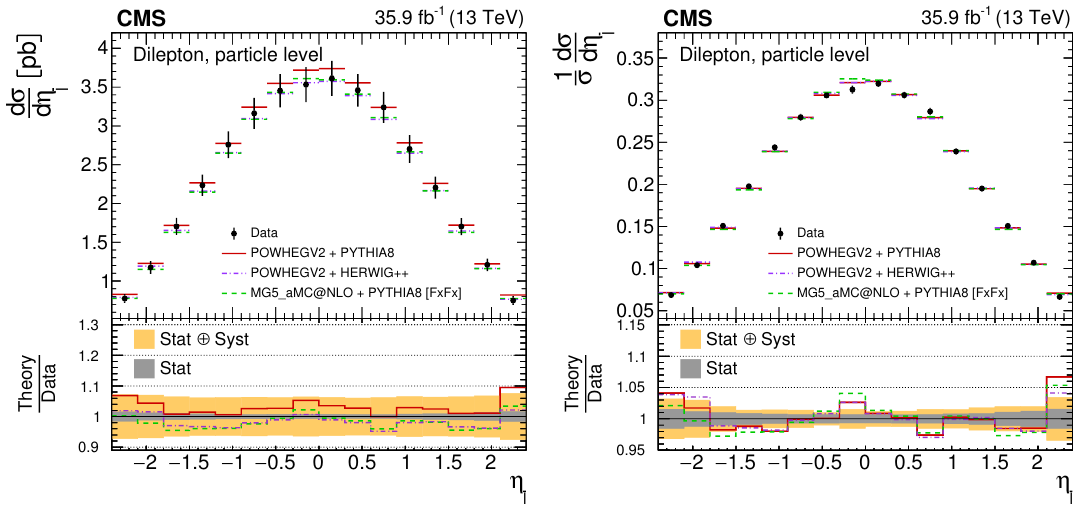
Figure 38 . The di(cid:11)erential tt production cross sections as a function of (cid:17) (cid:22) at the particle level are shown for the data (points) and the MC predictions (lines). The vertical lines on the points indicate the total uncertainty in the data. The left and right plots correspond to absolute and normalised measurements, respectively. The lower panel in each plot shows the ratios of the theoretical predictions to the data. The dark and light bands show the relative statistical and total uncertainties in the data, respectively.